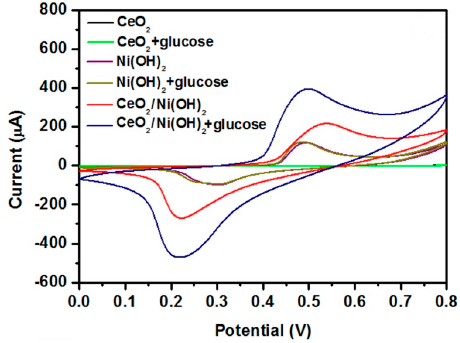
Figure 4. CVs of CeO 2 /CPE, Ni(OH) 2 /CPE, and CeO 2 /Ni(OH) 2 /CPE in the absence and presence of 1 mM glucose in 0.1 M NaOH solution at 50 mV/s scan rate.